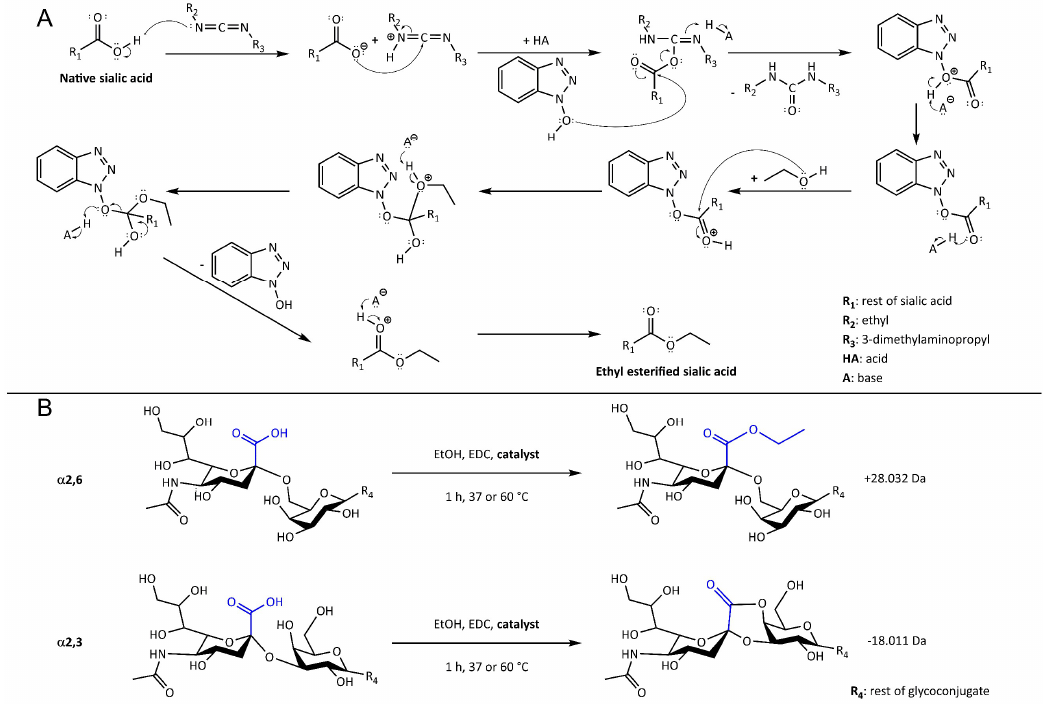
Figure 2. Reaction mechanism ( A ) and scheme ( B ) for the linkage-specific sialic acid derivatization